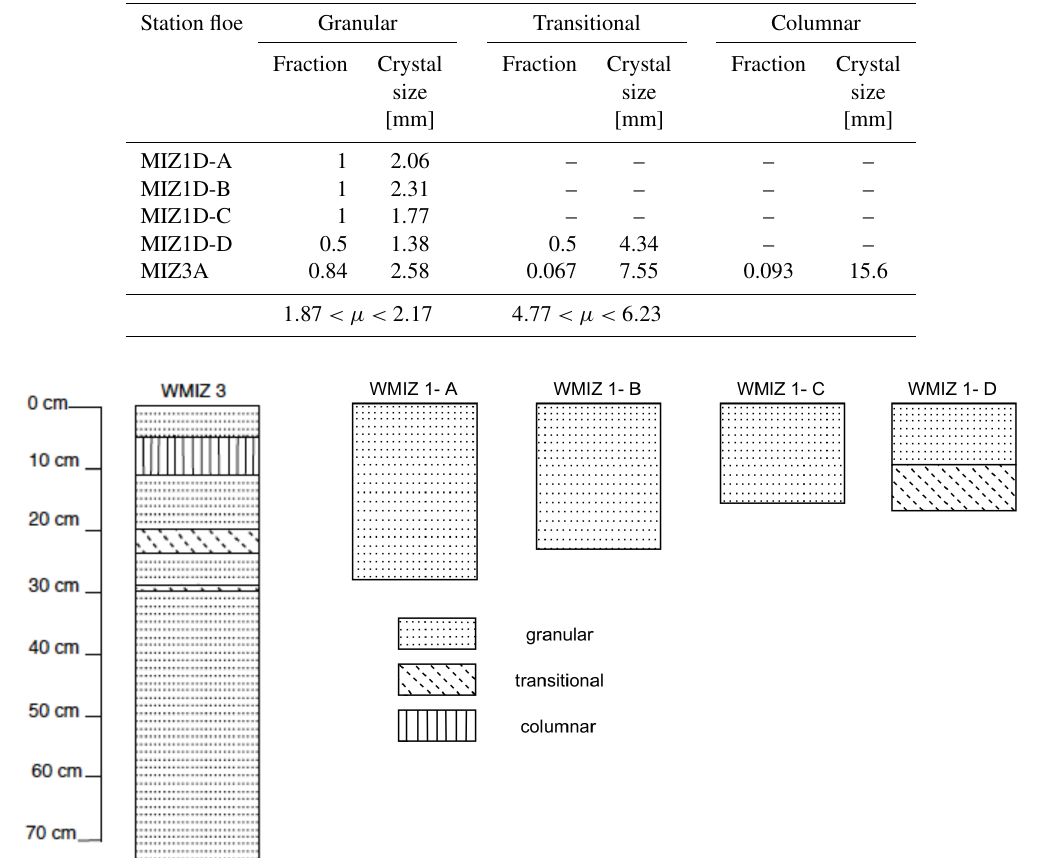
Figure 10. Stratigraphy diagrams for consolidated pack ice core M03-CP-01-A (WMIZ 3) and pancake ice cores M01-CP-01-A (WMIZ 1- A), M01-CP-01-B (WMIZ 1-B), M01-CP-01-C (WMIZ 1-C) and M01-CP-01-D (WMIZ